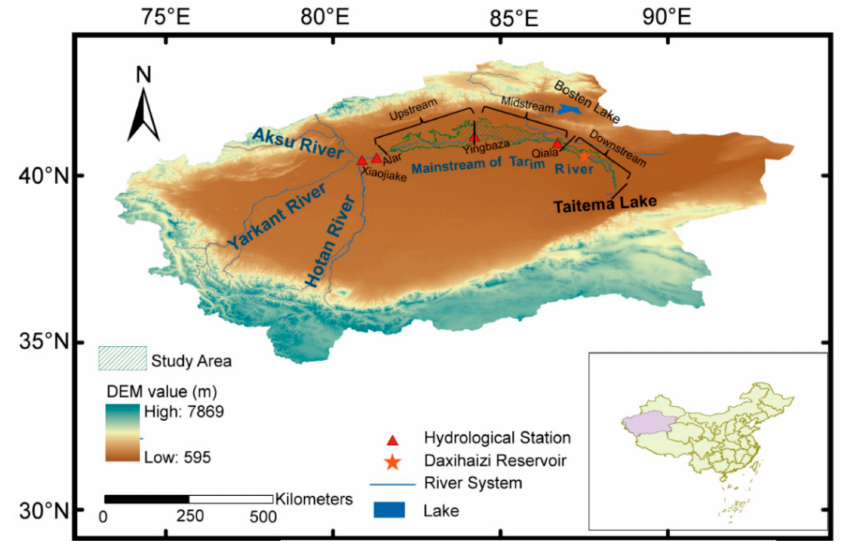
Figure 1. The study area of the Tarim River Basin, including digital elevation model (DEM), hydro- logical stations, and locations of the upper three tributaries (i.e., Aksu, Yarkant, and Hotan Rivers) and the